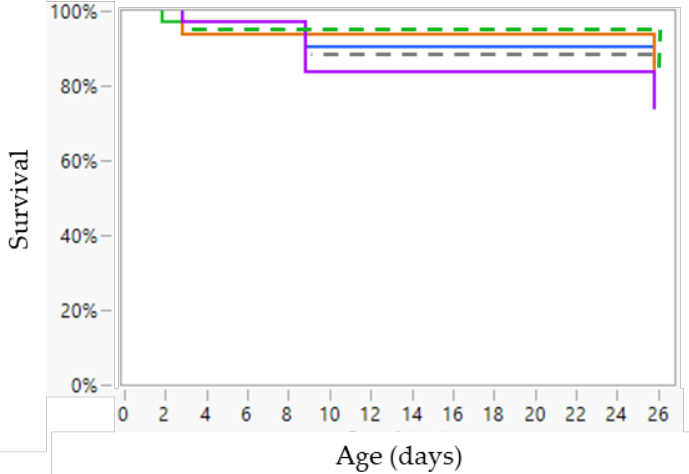
Figure 8. Cumulative mortality of low birth weight (LBW) piglets from Farm B (n = 150) at different time points (day 1, 2, 3, 9, and two days after weaning [day 26]) per treatment: no treatment (green line), sham one dose (orange line), sham three doses (purple line), dense milk replacer one dose (grey line) or dense milk replacer three doses (blue line). Cox’s proportional hazard model showed no effect of treatment ( p = 0.999). The animals had the greatest risk of dying between day 3 and 9 ( p < 0.001).